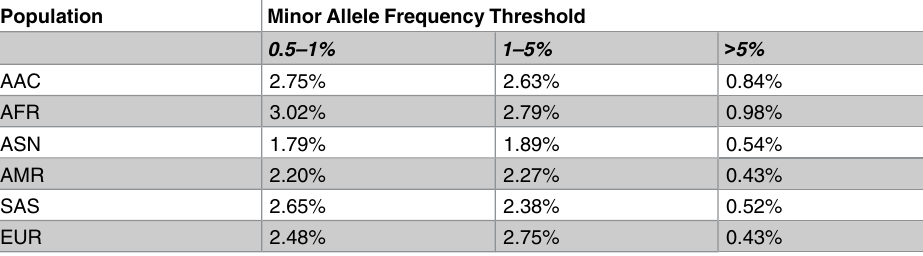
Table 4. Enhanced Imputation Accuracy with Custom Content